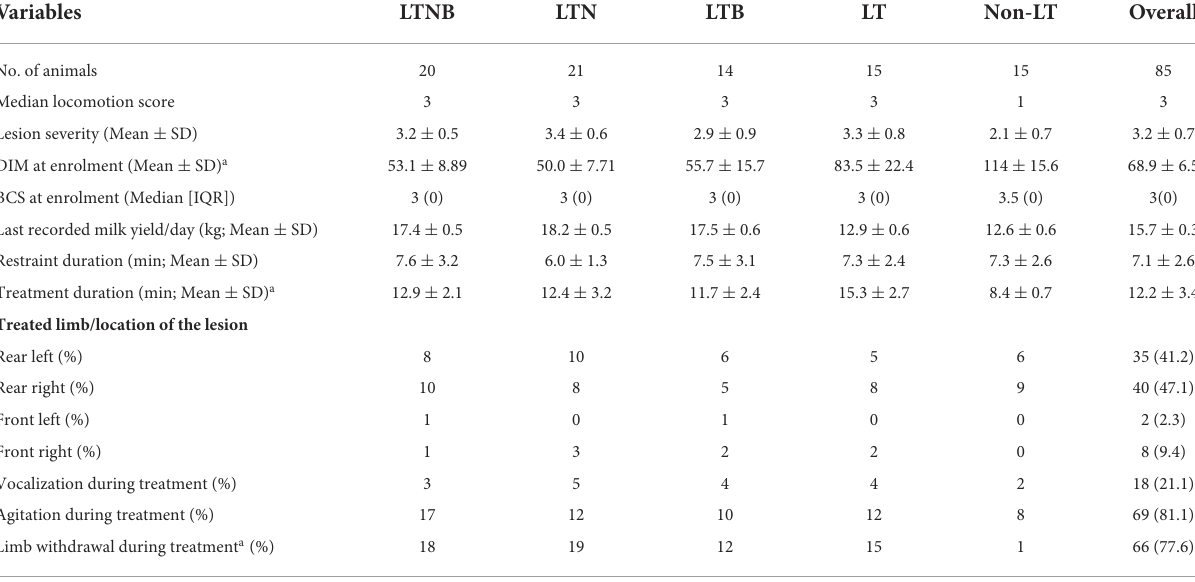
TABLE 4 Descriptive statistics of primiparous cows enrolled in the five experimental groups.